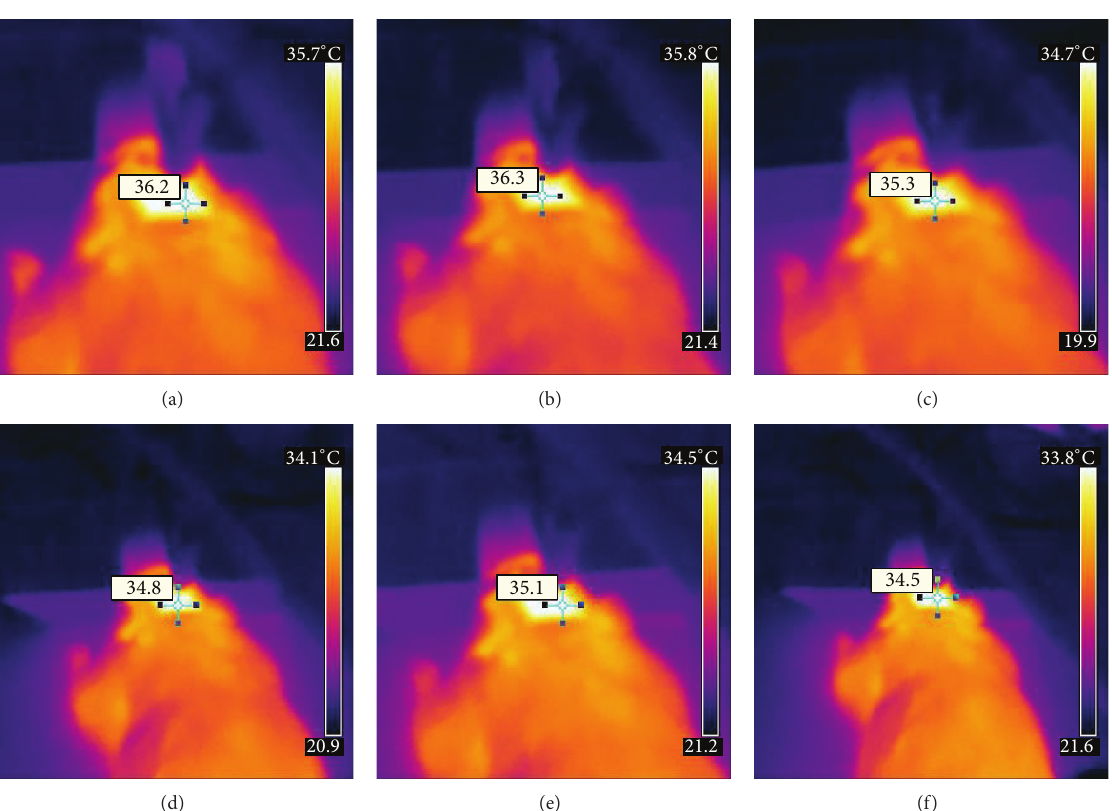
Figure 5: Six thermal images from an anesthetized rat before (a), during ((b), (c), and (d)), and after ((e) and (f)) red light stimulation at the Baihui acupoint. Note the decrease of the temperature during and after red light